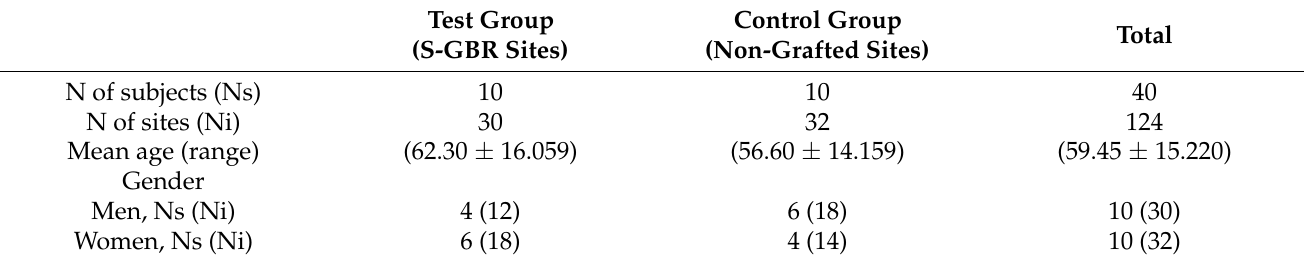
Table 1. Characteristics of test and control group.